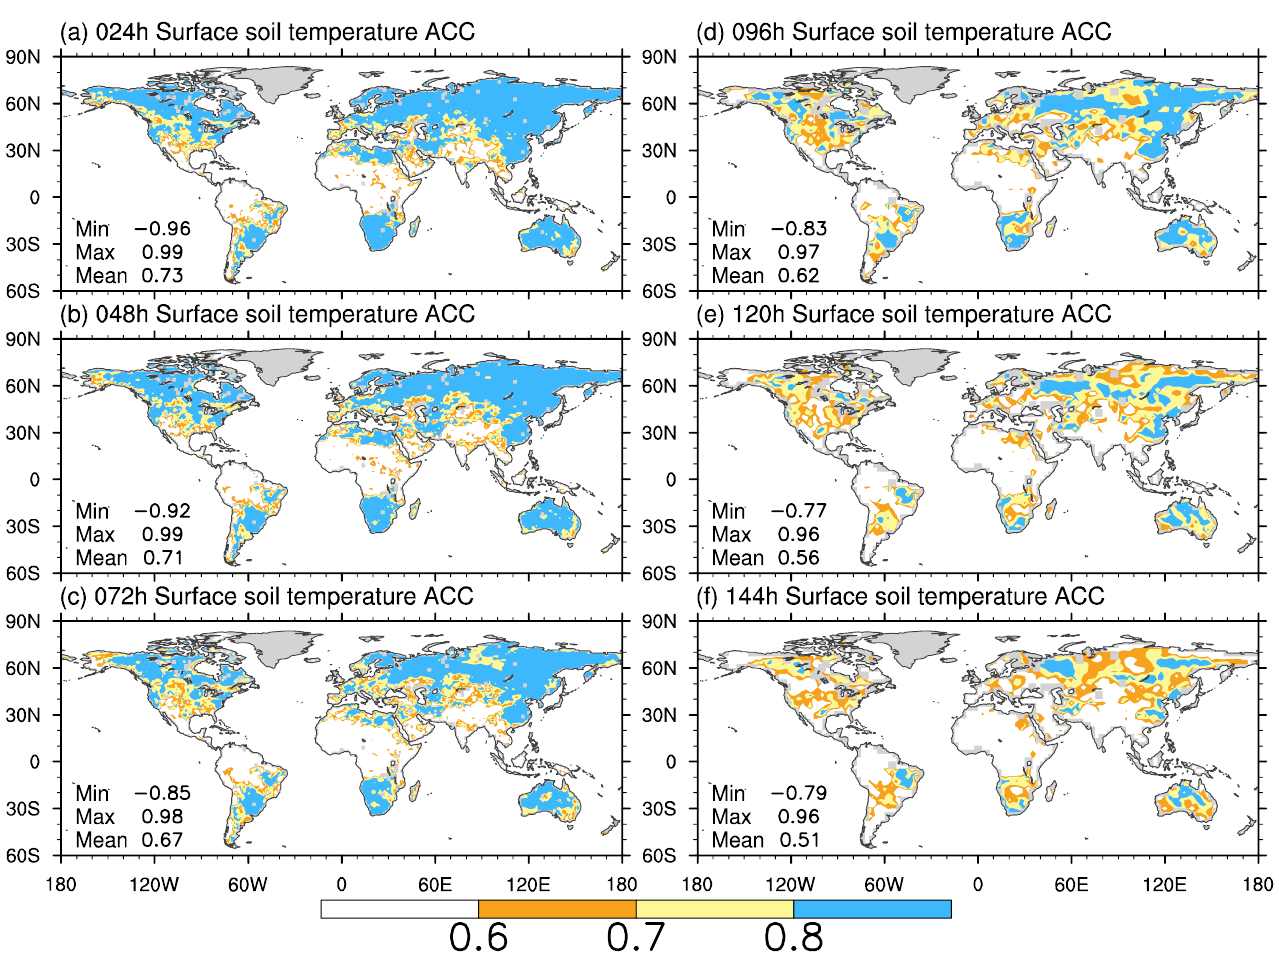
Figure 11. Spatial distribution of anomaly correlation coefficient (ACC) of surface soil temperature between GRAPES_NEW ( a ) 24 h forecast; ( b ) 48 h forecast; ( c ) 72 h forecast; ( d ) 96 h forecast; ( e ) 120 h forecast; ( f ) 144 h forecast results and GLDAS at the corresponding time. Table 10. ACC of surface soil temperature between GRAPES forecast and GLDAS over different Overall, after updating CoLM schemes, GRAPES_NEW shows a smaller RMSE and a regions. larger ACC on surface soil moisture and soil temperature than